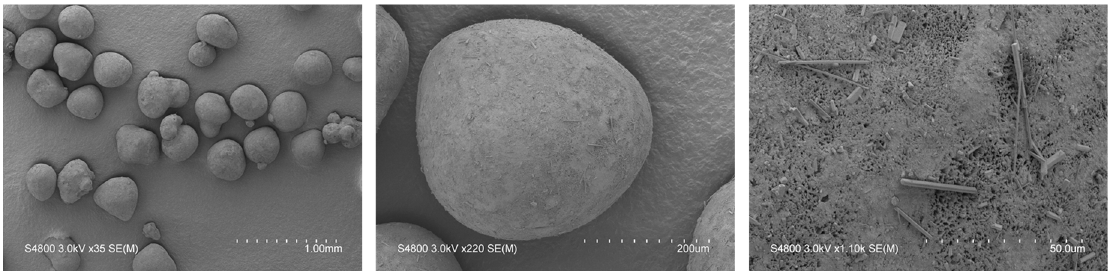
Figure 12. Particle size distribution of spray granulated NAM pellets.